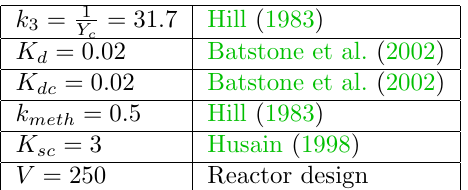
Table 1: Parameters with known values. (Units are listed in Appendix A.2.)